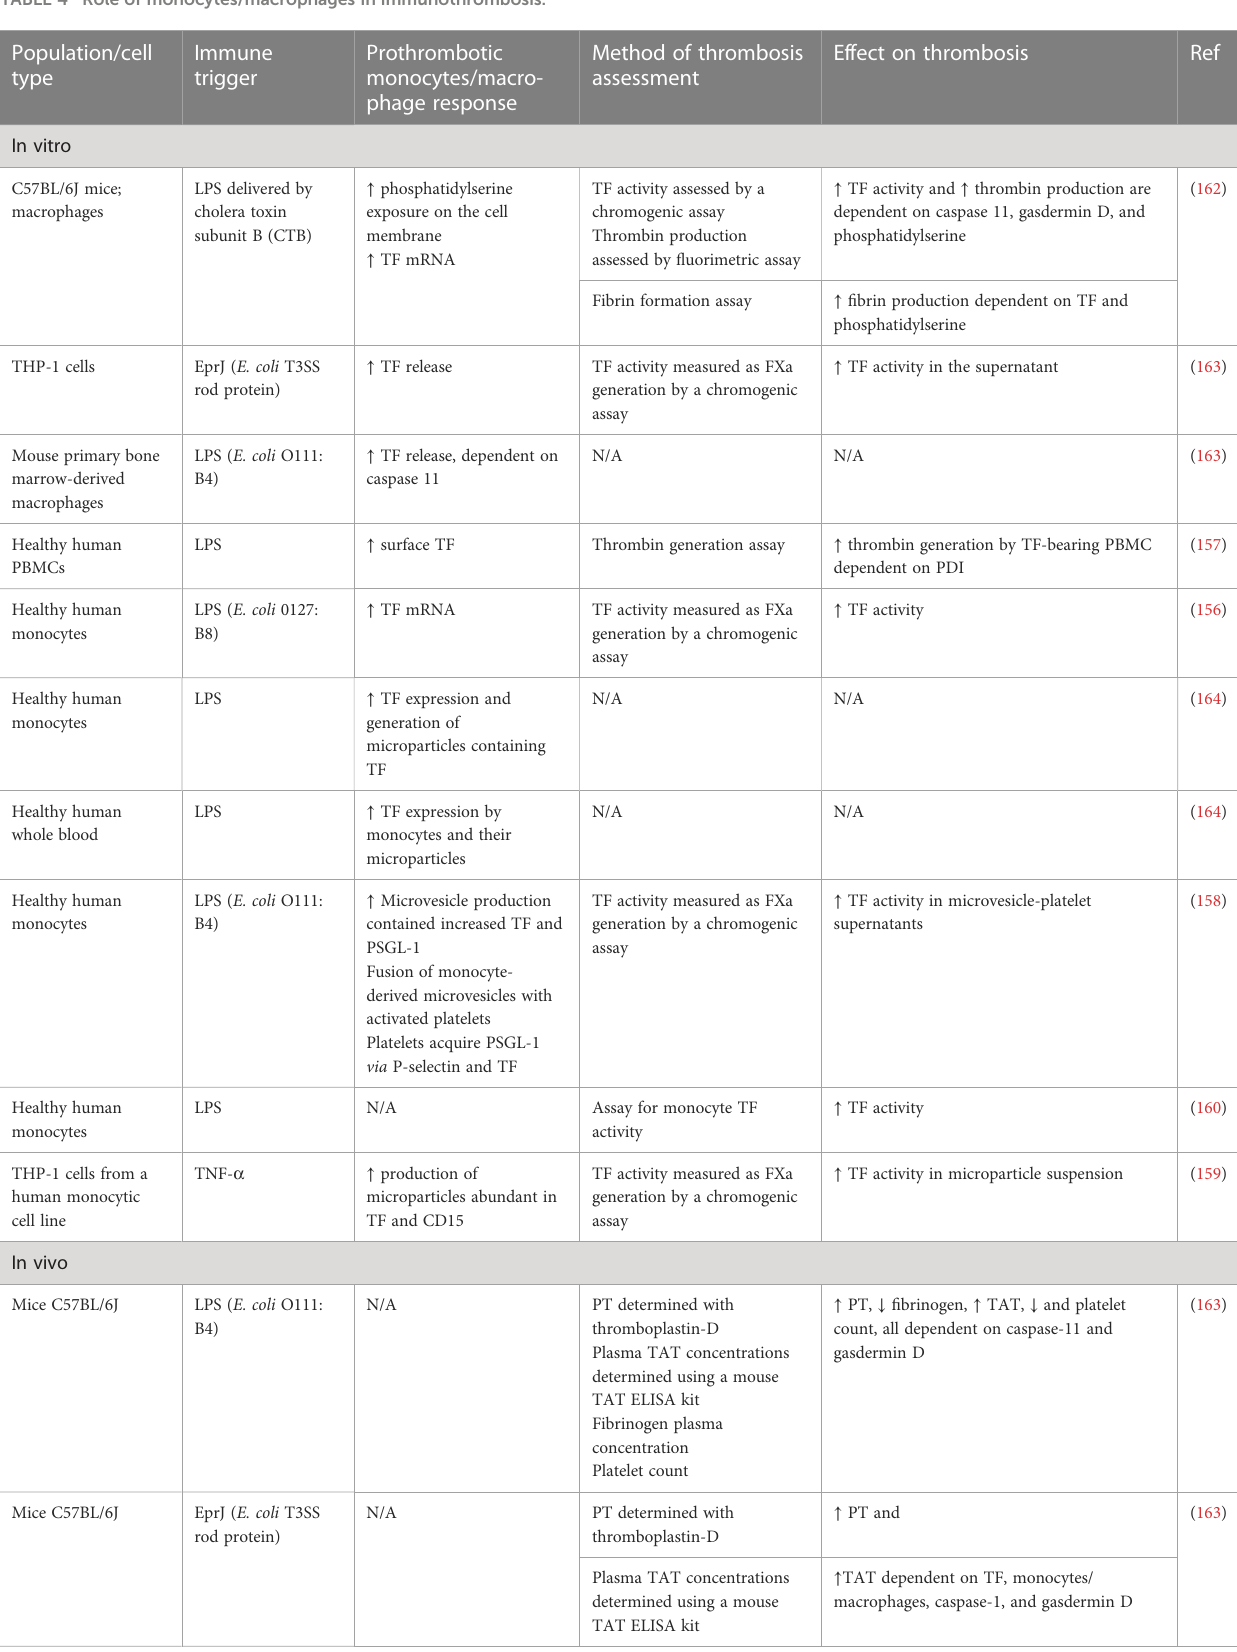
TABLE 4 Role of monocytes/macrophages in